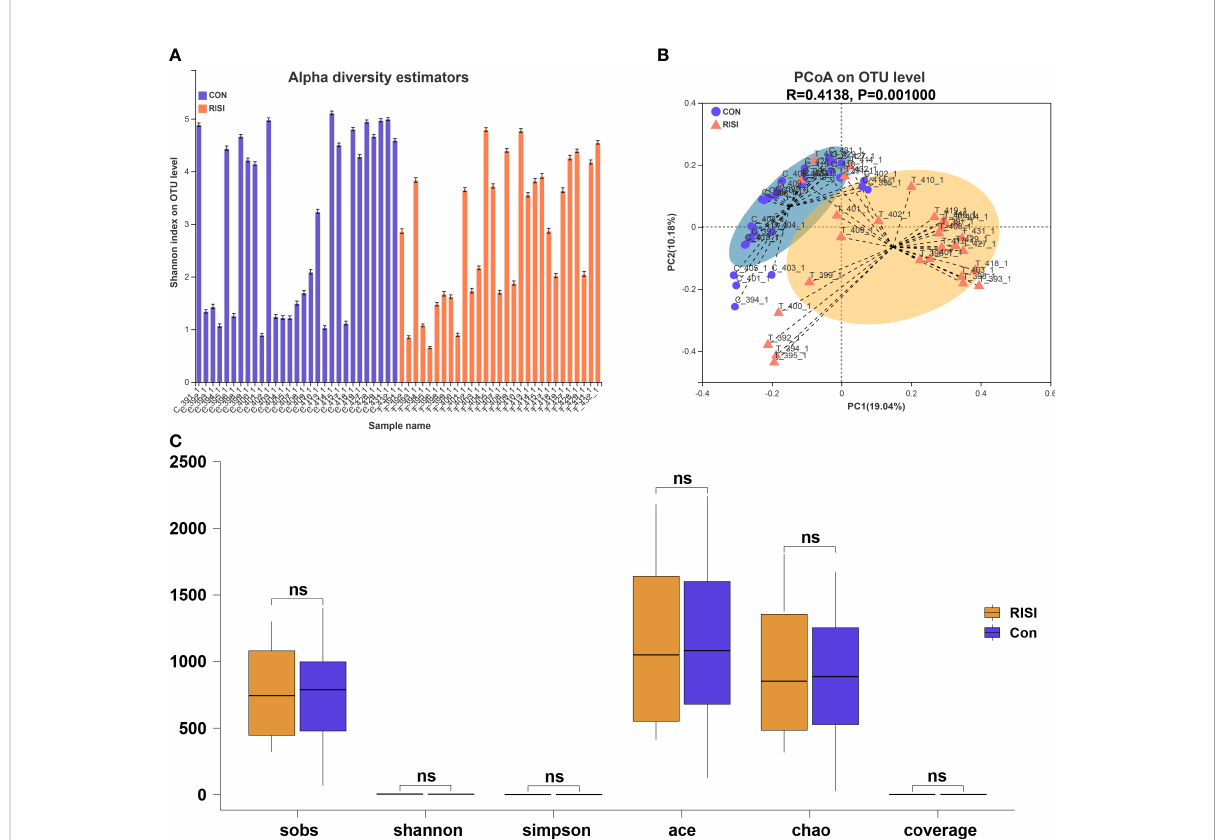
FIGURE 1 Diversity analysis of cutaneous microbiomes. (A) Alpha diversity bar charts between the radiation-induced skin injury ( RISI ) group and healthy controls ( CON ). (B) Beta diversity estimation. Principal coordinates analysis (PCoA) of RISI and CON based on unweighted UniFrac distance matrices. (C) Box plot of the comparison of the alpha diversity indices. ns: not sini fi